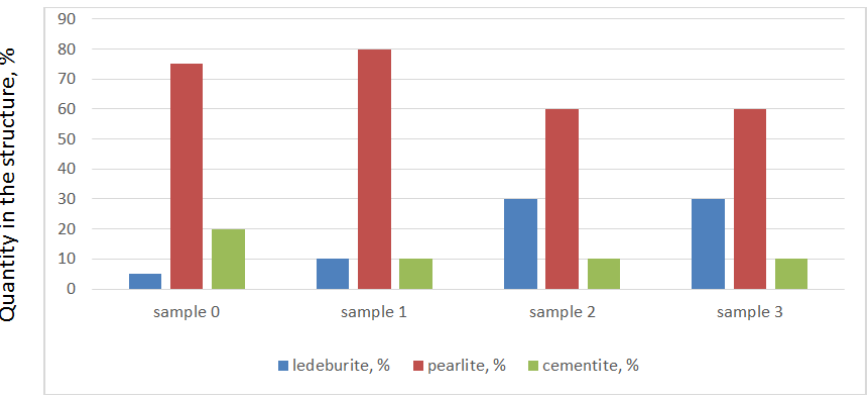
Figure 4. The ratio of structural components in low-chromium cast iron before and after modification.